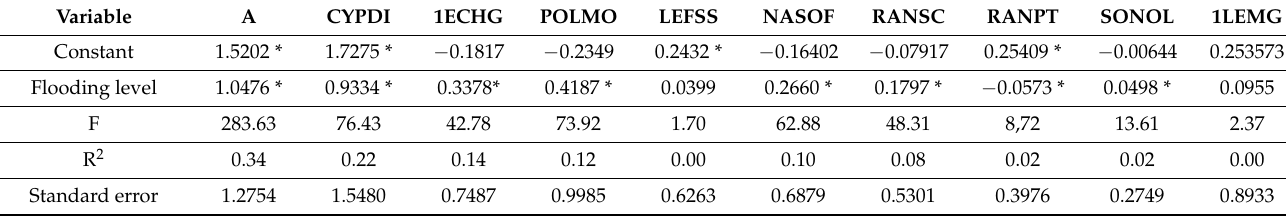
Table 5. Effect of the winter flooding level on the total number of germinable seeds and the number of each species in the rice soil seedbank using a concurrent regression model.